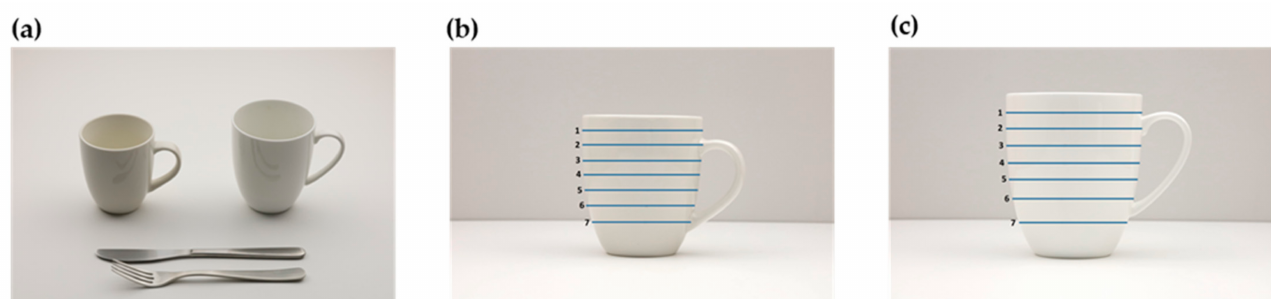
Figure 3. Examples of guide photographs. ( a ) Bananas, ( b ) sandwiches, and ( c ) cookies.